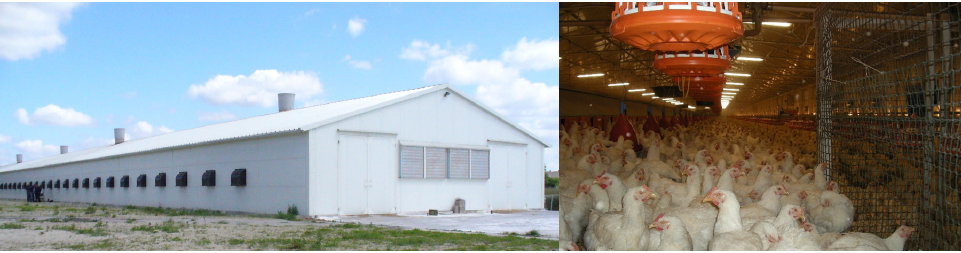
Figure 1. The studied poultry house (authors